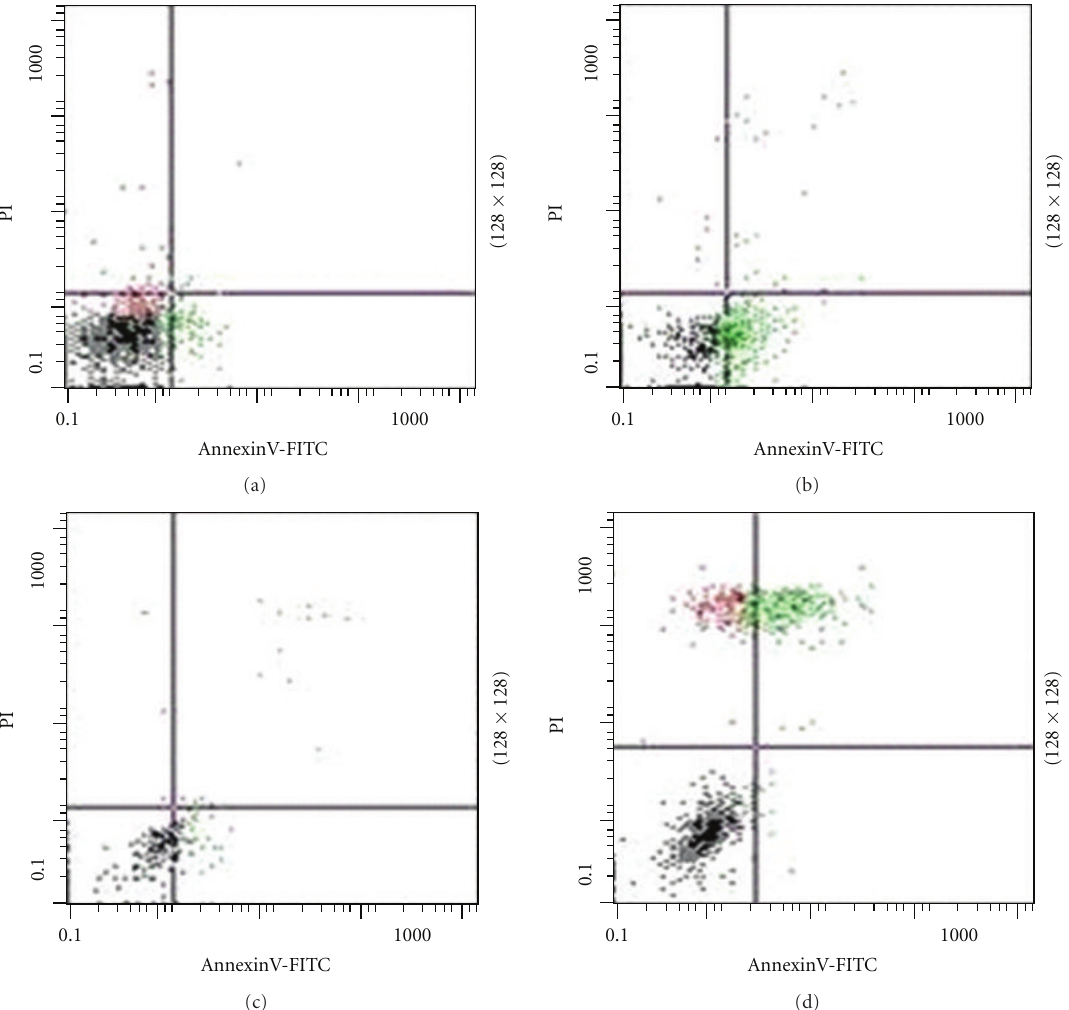
Figure 4: A549 cell apoptosis under hypoxia. (a) control group; (b) radiotherapy alone group; (c) endostar alone group; (d) endostar + radiotherapy. Table 5: Cell cycle in each group under normoxia and hypoxia (%, x ± S).